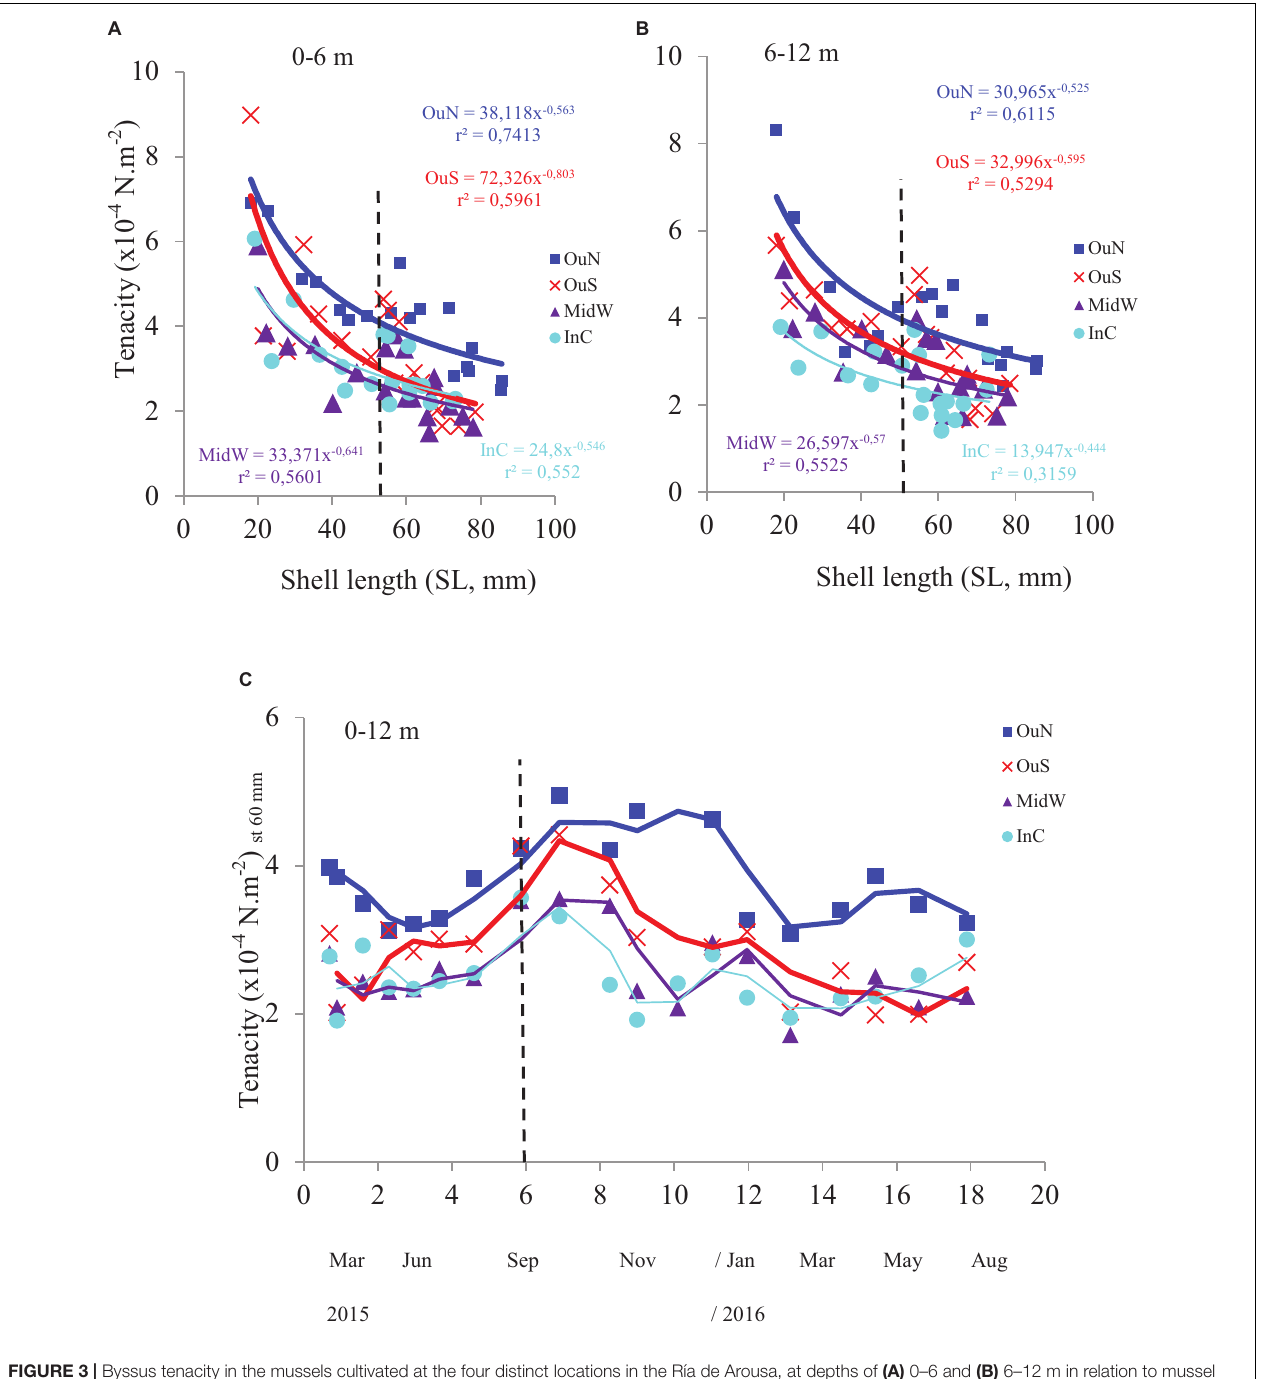
FIGURE 3 | Byssus tenacity in the mussels cultivated at the four distinct locations in the Ría de Arousa, at depths of (A) 0–6 and (B) 6–12 m in relation to mussel size (SL, mm). Variability in byssus tenacity (as mean values for the entire length of the cultivation rope; moving average) in relation to (C) cultivation time once standardized to a common mussel size of 60 mm shell length. The dashed line represents the timing of the thinning out process usually carried out between seeding and